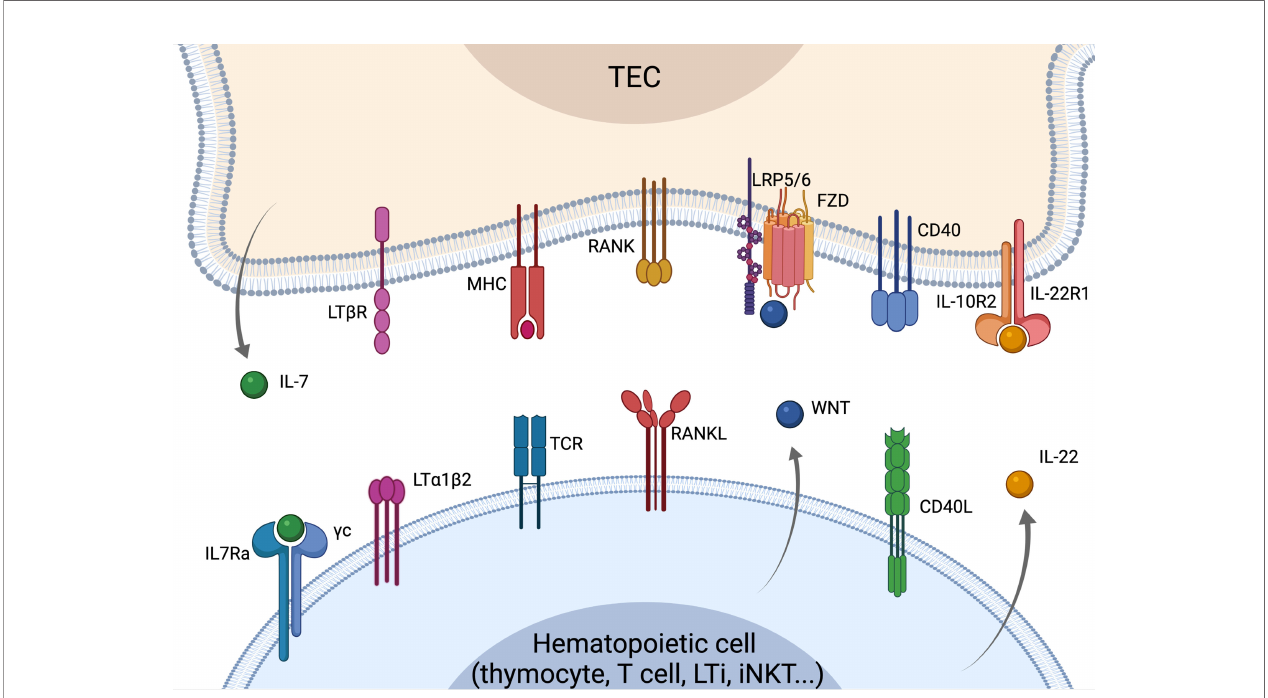
FIGURE 1 | Overview of the crosstalk signals driving TEC development, differentiation and regeneration. Recover of thymus function is strictly dependent on the crosstalk signals between TECs and cells of the hematopoietic compartment. LT a and RANKL are mostly provided by SP thymocytes leading to mTEC maturation and differentiation. RANKL is overexpressed by CD4 thymocytes and LTi cells upon insults and can drive the recovery of thymus function. WNT signaling regulates TEC proliferation and homeostasis, while CD40L is involved in TEC maturation and proliferation. LTi- and T-cells-derived IL-22 is key in sustaining TEC proliferation and thymus recovery upon insults. IL-7 is mostly produced by cTEC acting as a key mediator of thymocyte maturation and proliferation. Elements of the fi gure were generated using